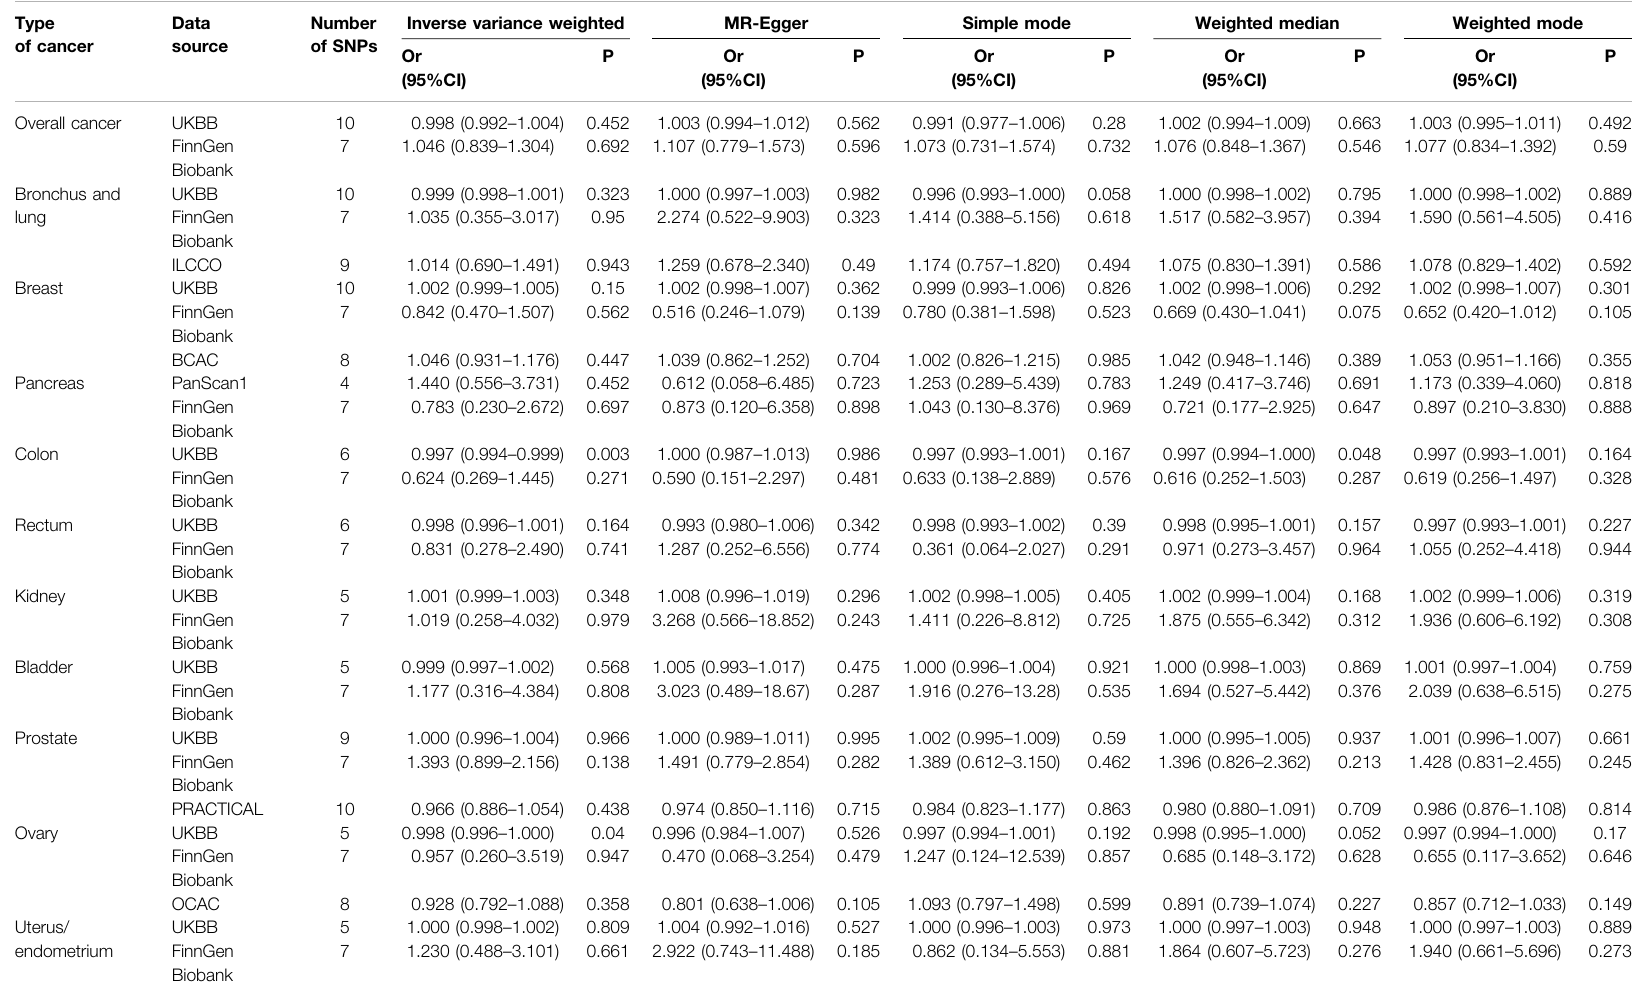
TABLE 3 | Associations between genetically predicted vitamin C and risk of